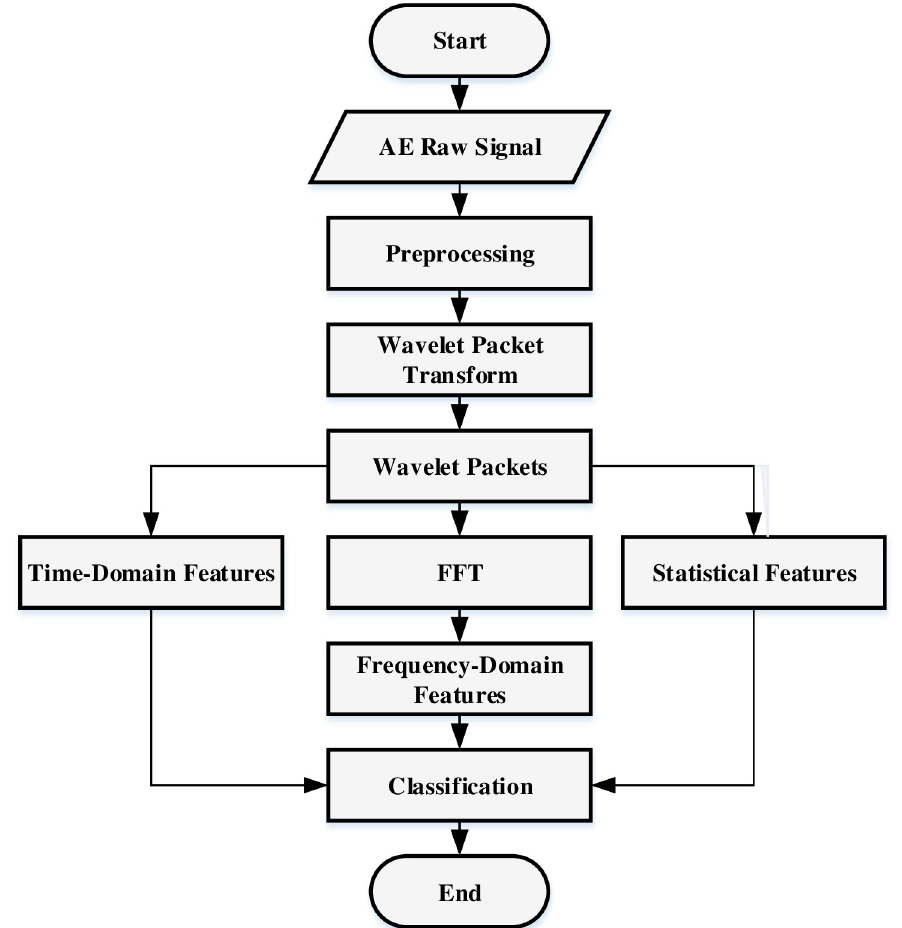
Fig 4. A flowchart of the proposed AE features extraction and classification